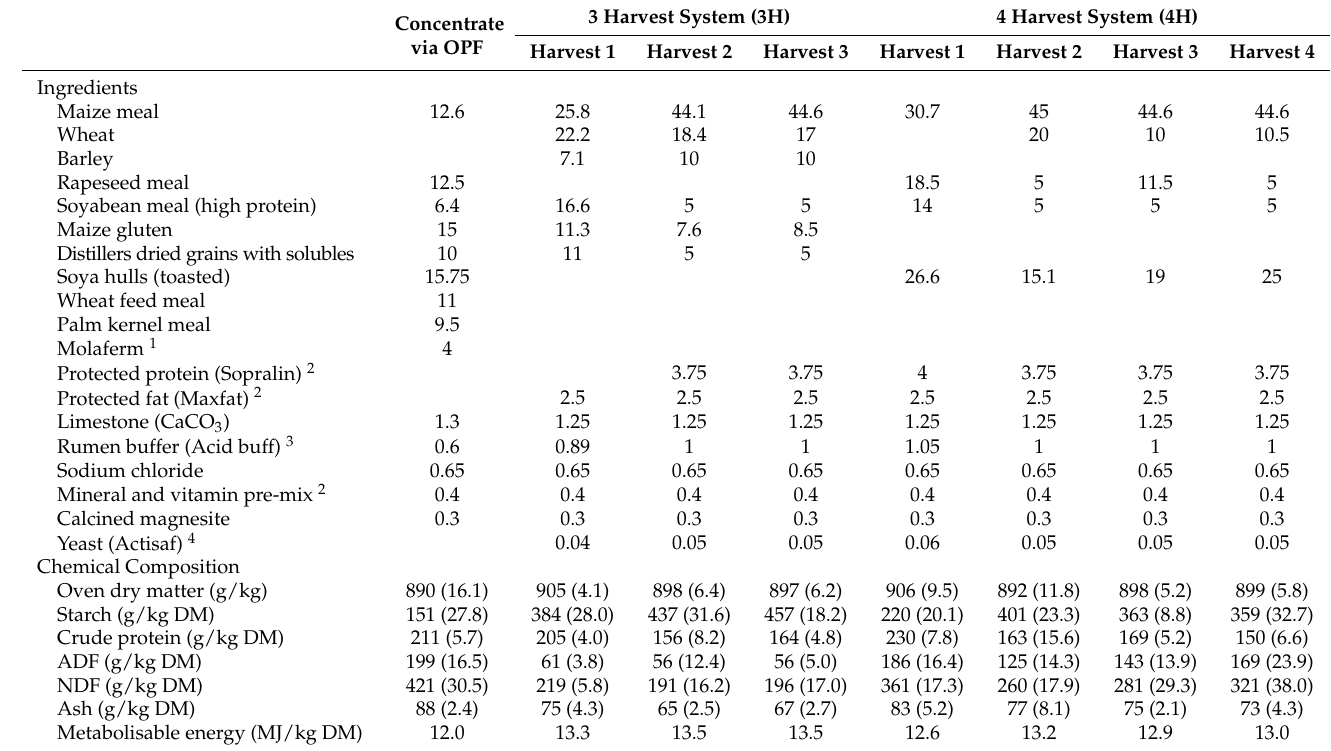
Table 1. Ingredient list (g/100 g fresh) and chemical composition (SD in parenthesis) of the con- centrate offered to all cows through the out-of-parlour feeding system (OPF), and of individual concentrates used to supplement each silage type within the three- (3H) and four-harvest (4H) silage production systems. 3 Harvest System (3H) 4 Harvest System Concentrate via OPF